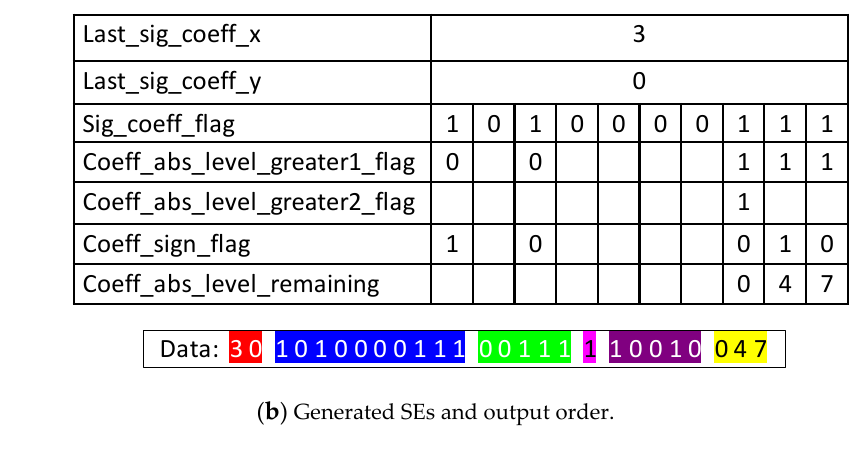
Figure 4. Process of residual SEs generation.